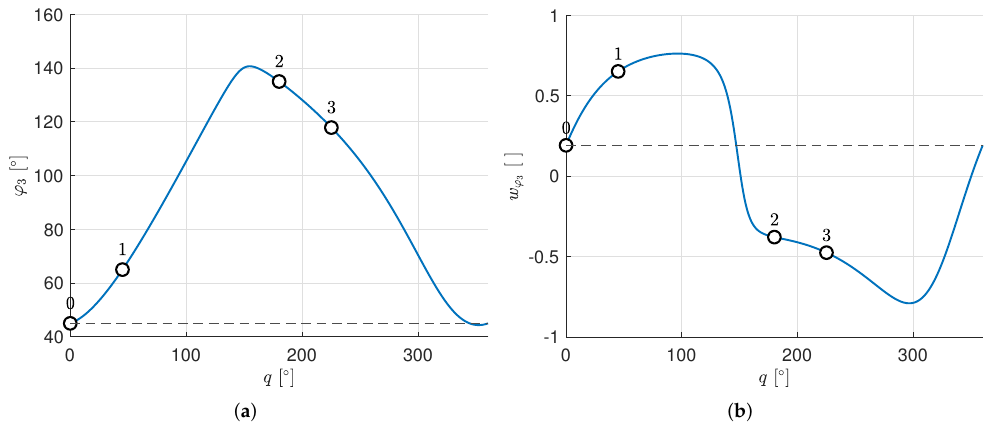
Figure 5. Rocker position ( a ) and speed ratio ( b ) for each crank configuration, where q is the displacement with respect to configuration 0. The dots represent the configuration 0 (to the left of each graph) and the three precision points (where q = δ 1, k with k = 1,2,3). Dashed lines show how ( 360 ◦ ) = w ϕ ( 0 ◦ ) . ϕ 3 ( 360 ◦ ) = ϕ 3 ( 0 ◦ ) and w ϕ 3 3